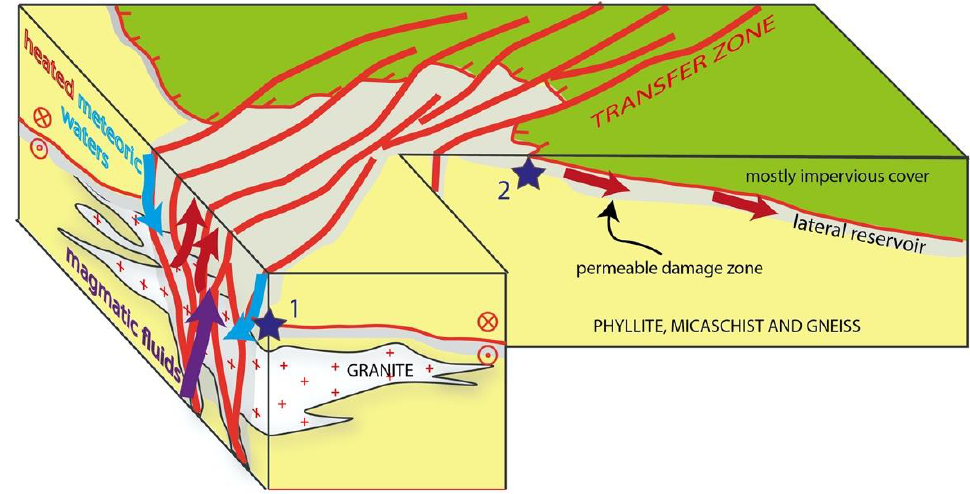
Figure 7. Structural sketch (not to scale) illustrating the relationships between geological structures, magma emplacement, and geothermal fluid flow (generating hydrothermal minerals) in the eastern Elba Island. Magmatic and geothermal fluids are channeled in the brittle transfer zone, and then stored in lateral reservoir. The structural location of the two areas described in the text are indicated: 1-deeper structural level, within micaschist; 2-shallower level, within quartzite Triassic rocks (after Reference [66]).